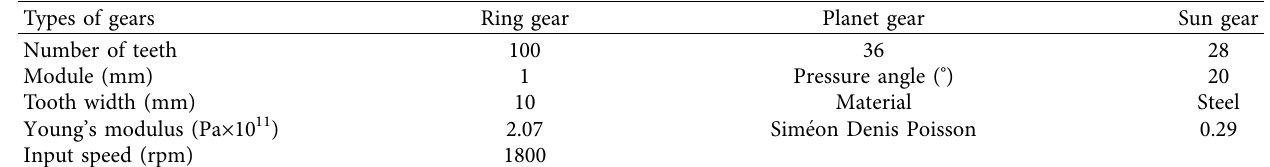
Table 1: Design parameters of planetary gear system.